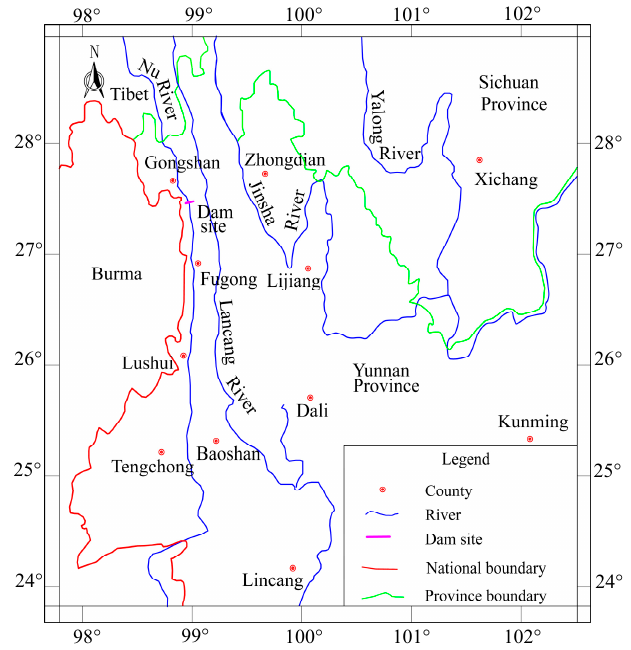
Figure 1. The location map of the Maji dam site area.